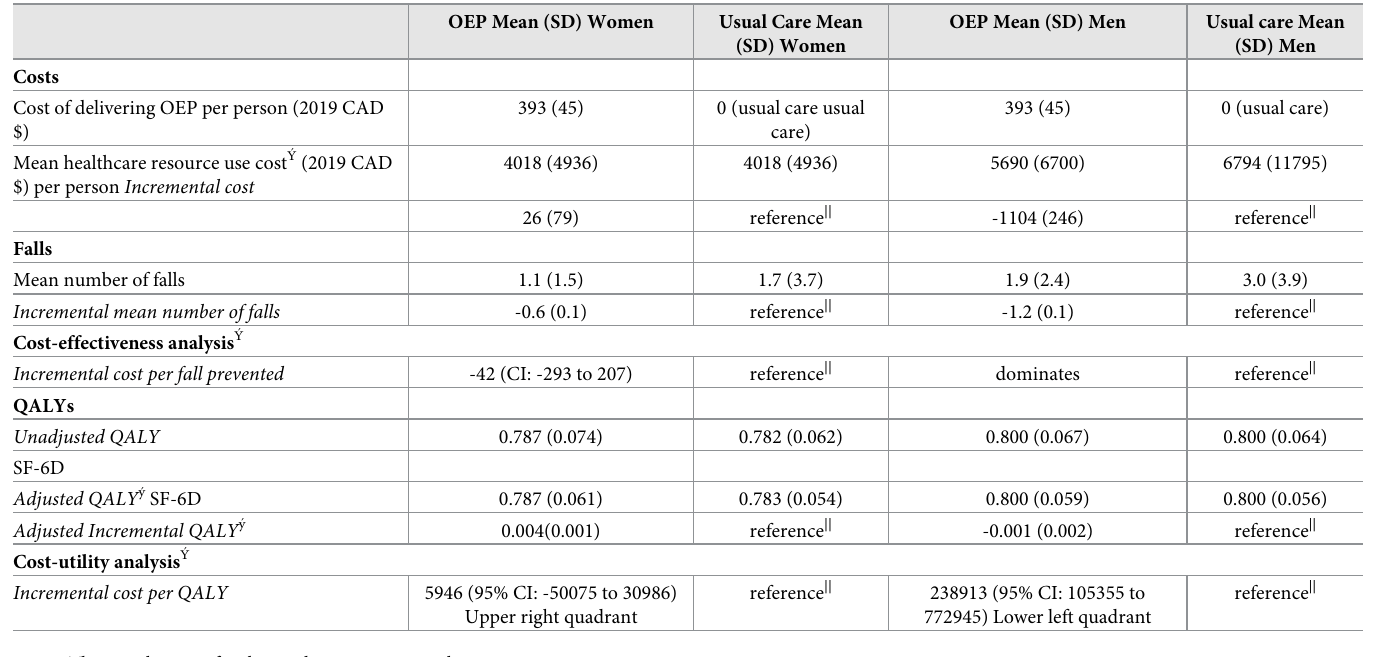
Table 3. Economic evaluation results of the cost-effectiveness and cost-utility study (imputed case analyses) stratified by